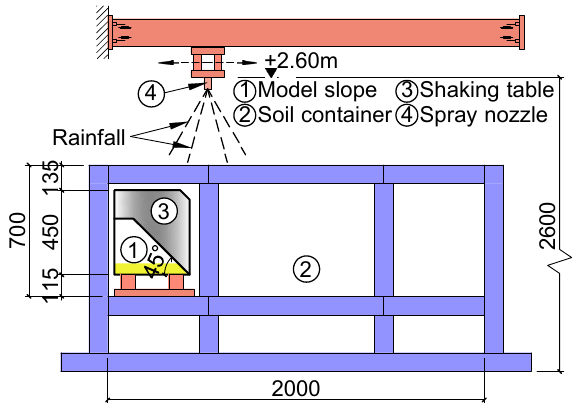
Figure 8. Overall view of apparatus in this study.